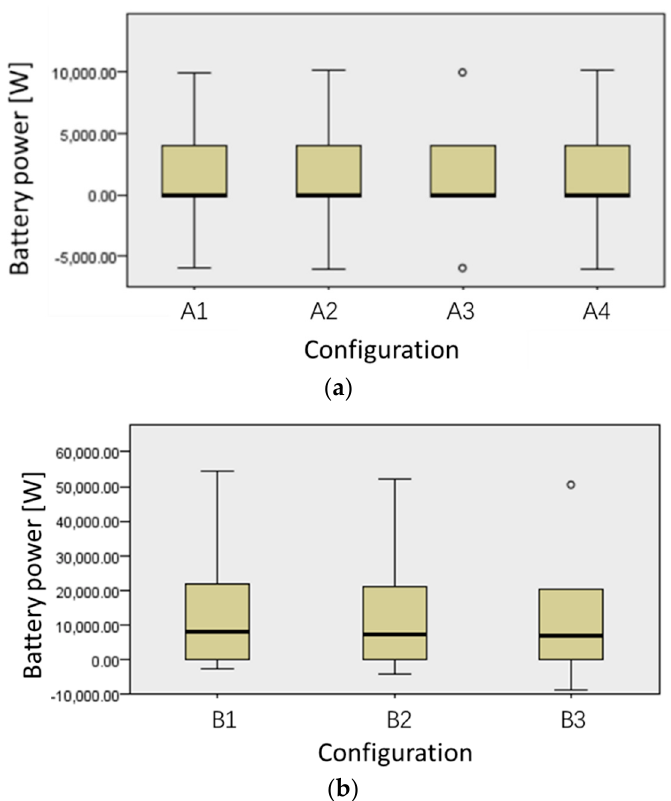
Figure 16. Box charts of vehicle speeds under ( a ) Configuration A1–A4 and ( b ) Configuration B1–B3.